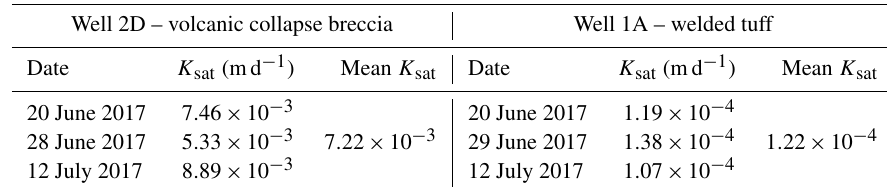
Table 1. Estimated saturated hydraulic conductivity in meters per day for three sampling events from wells 2D and 1A and their mean. Estimates were made by curve fitting 15min VWP data with the KGS model in AQTESOLV.